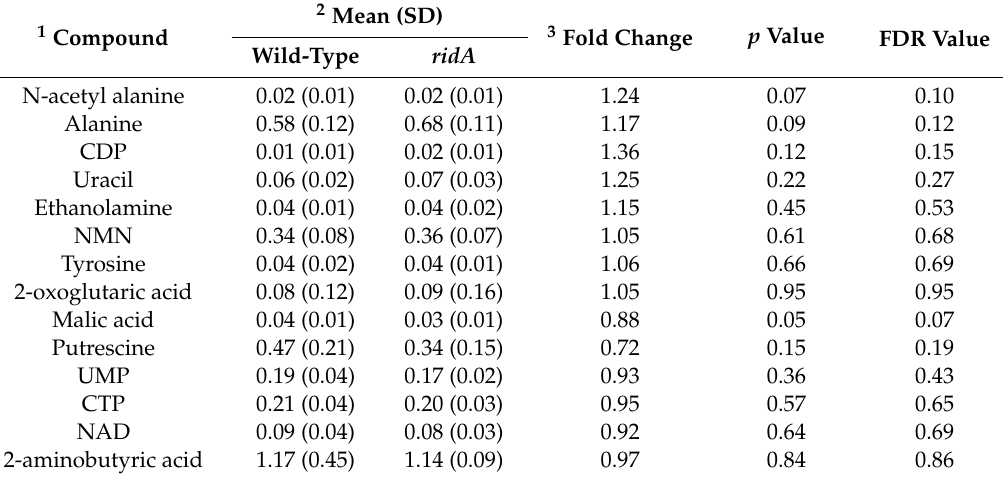
Table 2. Metabolites below statistical threshold for di ff erential